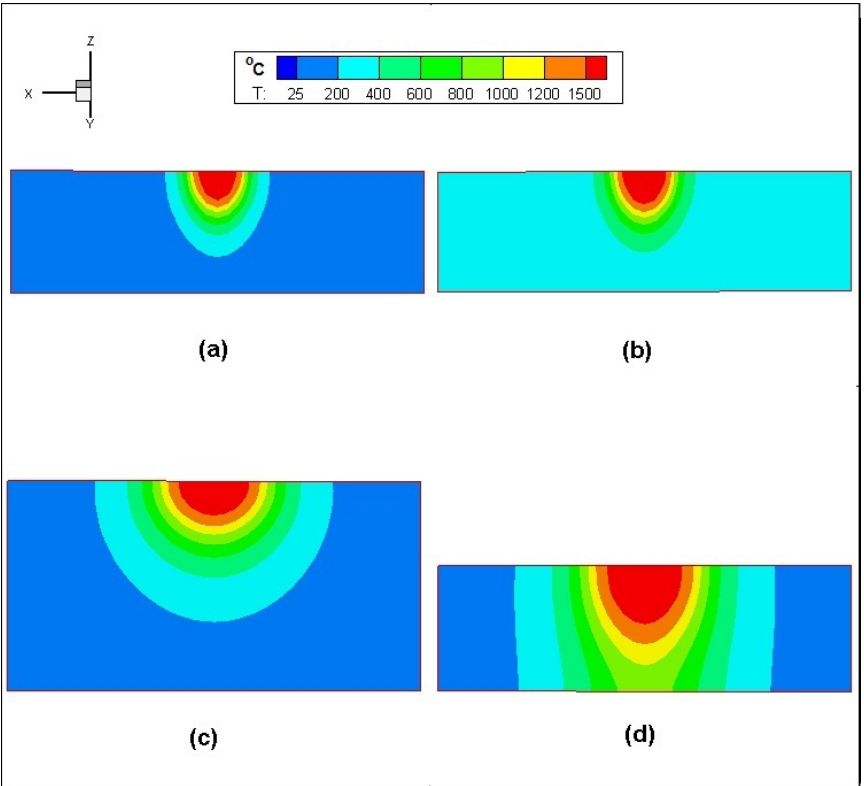
Figure 7 - Thermal profile in transversal sections of the plates: (a) 0.5 kJ mm -1 and 10 mm thick (after 9.2 s); (b) 0.5 kJ mm -1 and 10 mm thick plus preheating (after 9.2 s); (c) 3 kJ mm -1 and 25 mm thick (after 55 s) and (d) 3 kJ mm -1 and 10 mm thick (after 55 s)